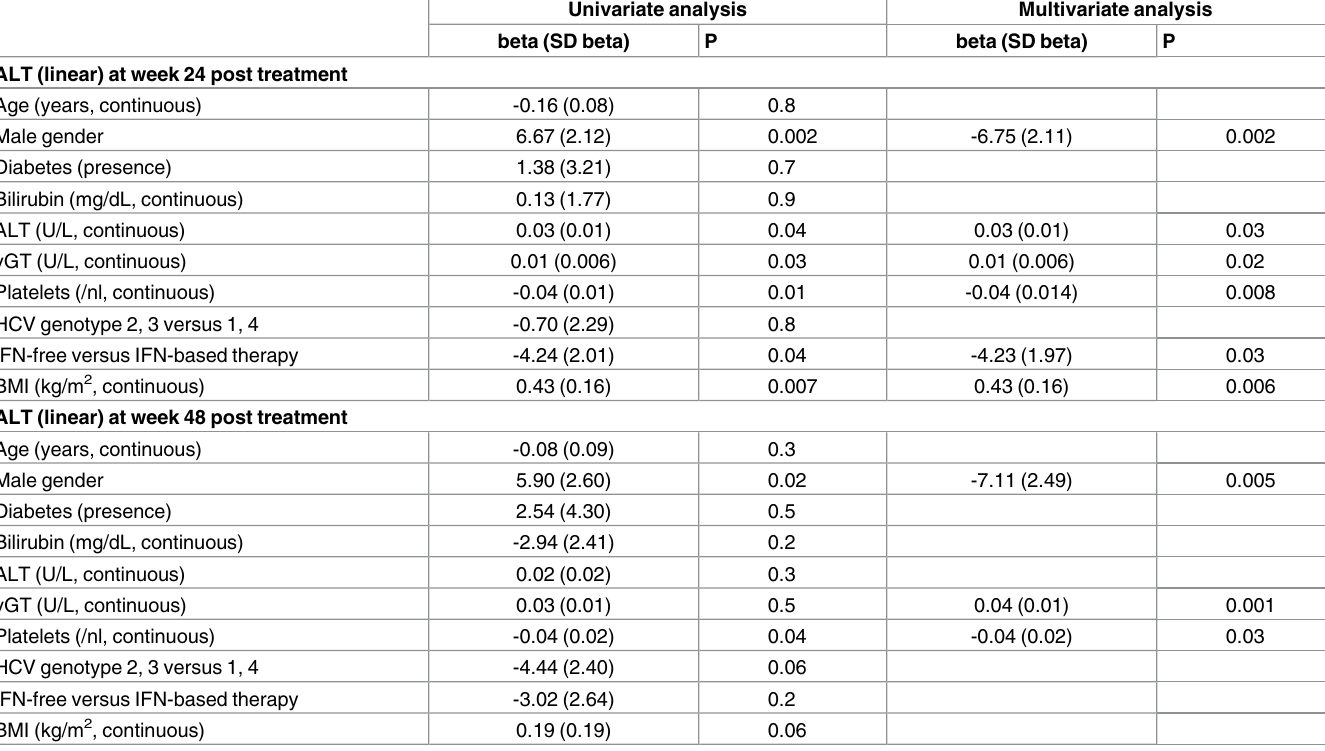
Table 3. Linear regression analysesof alanine aminotransferaseafter HCV